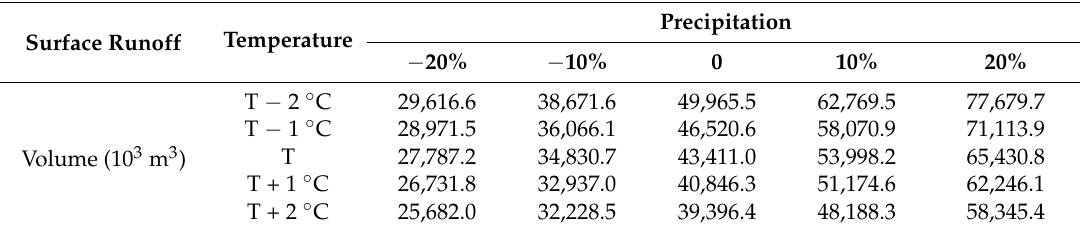
Table 4. Annual surface runoff simulated in different